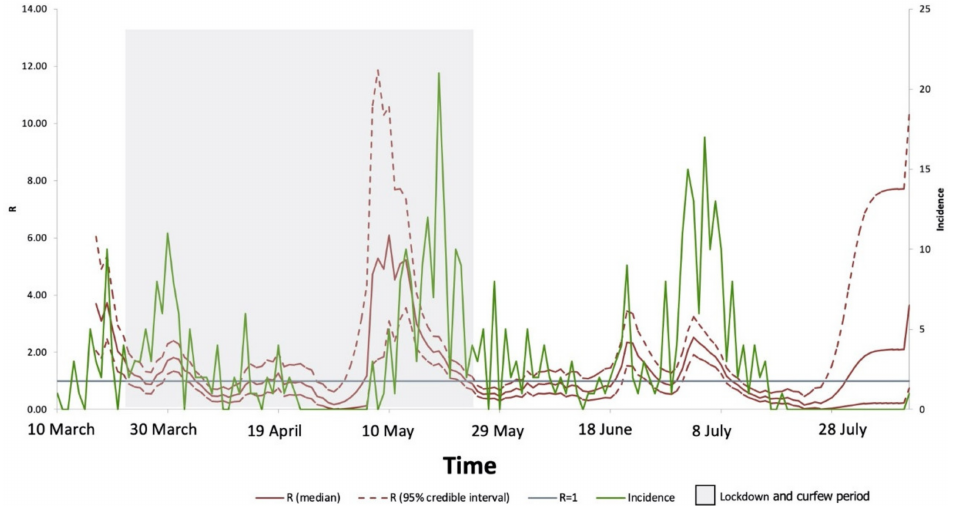
Figure 3. Instantons reproduction number (R t ) estimated using the EpiEstim package and modeled using a gamma distribution. Cases were detected for 155 days at KFSHRC. The average R value from 10 March to 11 August 2020, was 1.21. The red line shows the average median of R; dashed red line, confidence intervals; green line, incidence of cases reported; gray area, the lockdown period; and blue line, R = 1.